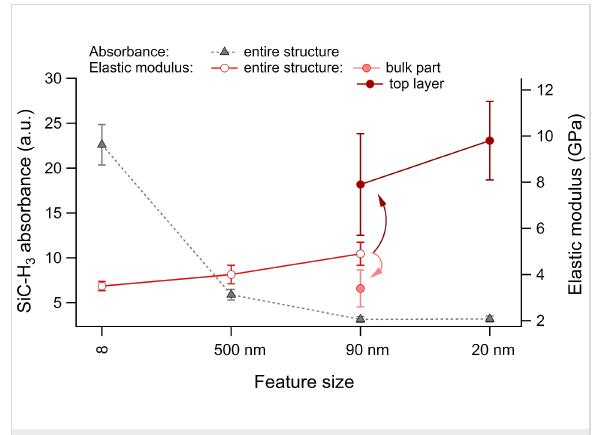
Figure 3: SiC–H 3 absorbance (AFM-IR) and Young’s modulus (CR- AFM) as functions of the feature size for unpatterned and patterned nanoporous organosilicates. Note: the error bars for the AFM-IR SiC–H 3 absorbance represents the maximum variability observed from spectra acquired at different sites with the same feature size. The details of the errors associated with the CR-AFM Young’s modulus measurements are covered in